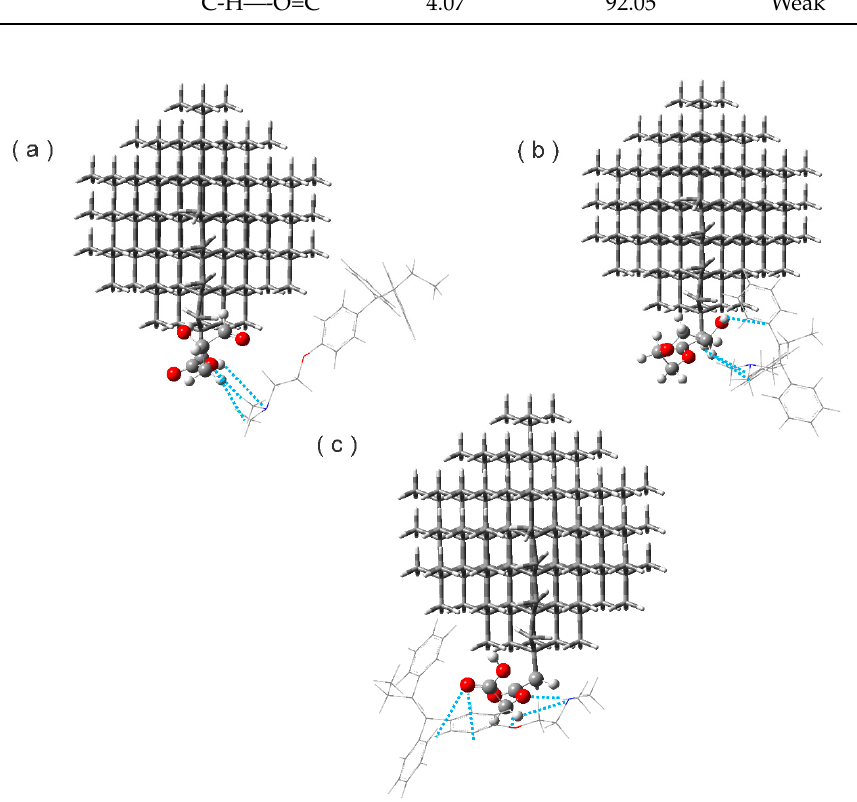
Figure 4. Hydrogen bonding in the ( a ) ND2HP - TAM complex; ( b ) NDPEG - TAM complex; and ( c ) NDPGA - TAM complex.